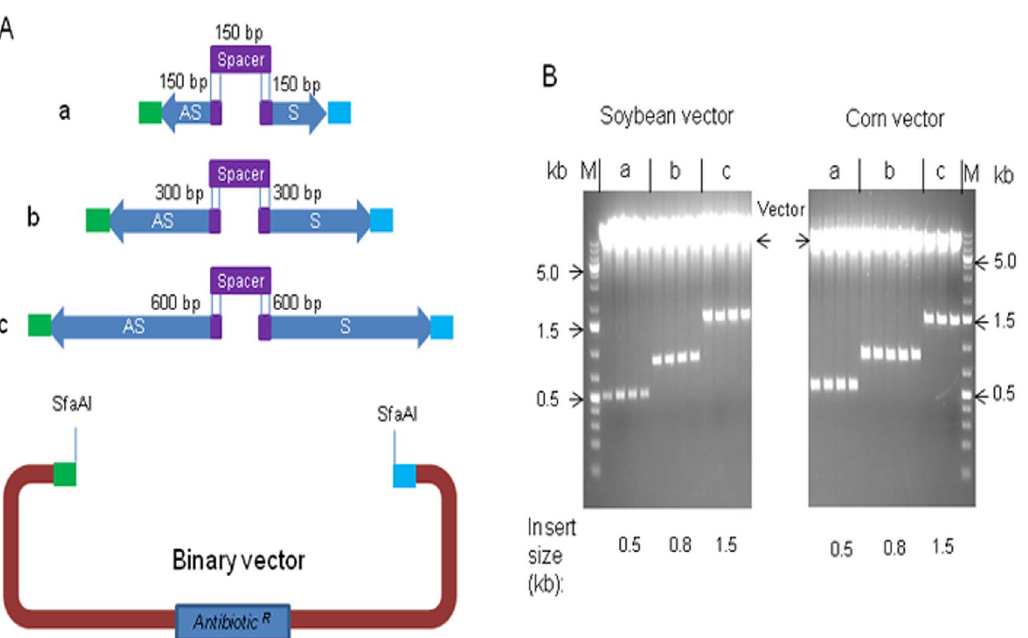
Fig. 7. Creation of RNAi constructs by Hot Fusion. (A) Design of RNAi elements for Hot Fusion. Anti-sense (AS) and sense (S) fragments of 150 bp (a), 300 bp (b) and 600 bp (c) overlapped with the vector and spacer as indicated. (B) Restriction digestion of plasmids containing RNAi elements. Three to five clones were analyzed for each construct (a, b and c). Each clone was digested by AscI and PmeI flanking the insert. The a, b and c contained the 150 bp, 300 bp and 600 bp of both anti-sense and sense fragments, respectively. M represents GeneRuler 1 kb Plus DNA